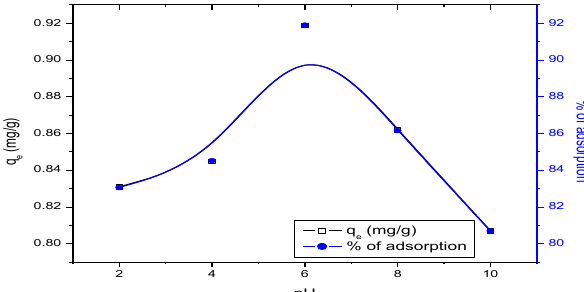
Figure 4. Effect of pH on the adsorption of fluoride by eggshell powder (experimental conditions: Initial fluoride concentration: 5.0 mg/L, adsorbent dose: 0.5 g/100 ml, agitation speed: 250 rpm, Contact time: 60 minutes, Temperature: 303